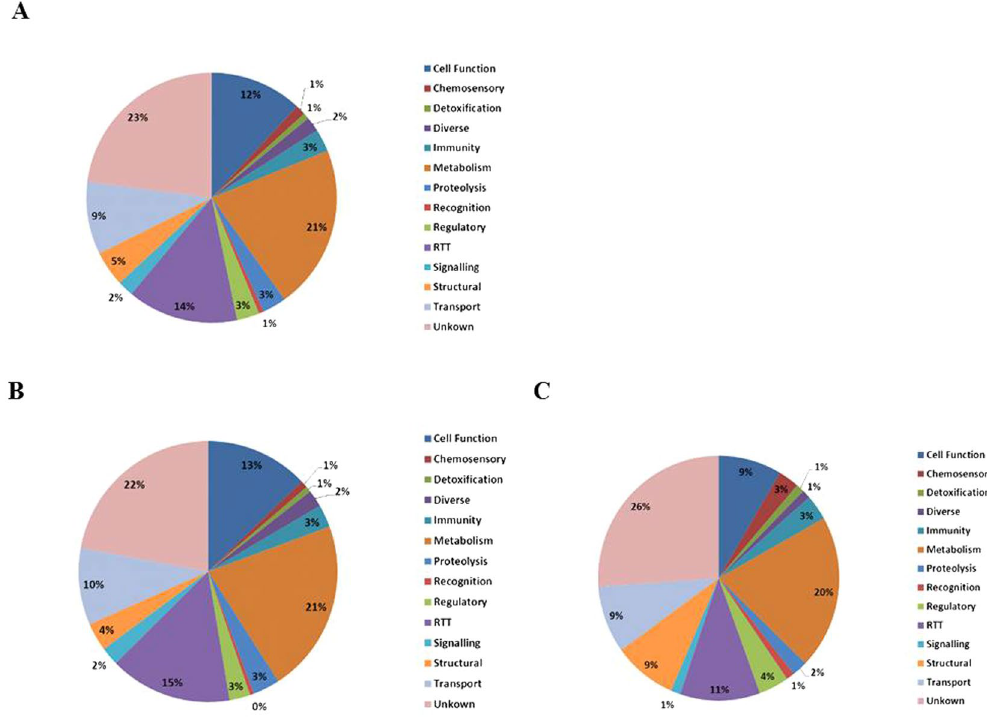
Figure 1. Differentially expressed genes in Anopheles stephensi salivary glands in response to Plasmodium berghei infection. ( A ) Distribution of differentially expressed transcripts by functional classes. ( B and C ) Distribution of upregulated ( B ) and downregulated ( C ) transcripts by functional classes. For annotation, gene identifiers were obtained from VectorBase (www.vectorbase.org) and compared to the corresponding sequences in A. gambiae